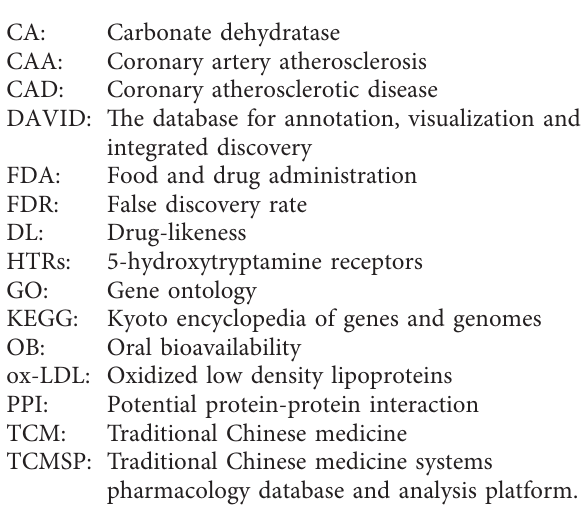
Table S1: Active components in four herbal strategies. Table S2: Common and unique component in four herbal strategies. Table S3: Targets of different components in all herbal strategies. Table S4: Targets of each herbal strategy by deduplication. Table S5: Common targets of different components in herbal strategy I, II, III, and IV. Table S6: Common and unique target in four herbal strategies. Table S7: GO and KEGG pathway enrichment analyses of targets in four herbal strategies. Table S8: Score of po- tential protein-protein interactions. Table S9: Interaction count of targets. Table S10: Targets of three familiar drugs in DrugBank. Table S11: Symbols associated with coro- nary artery atherosclerosis in GeneCards. Table S12: Common and unique target in coronary artery athero- sclerosis, herbal strategies, and familiar remedies. ( Sup- plementary Materials